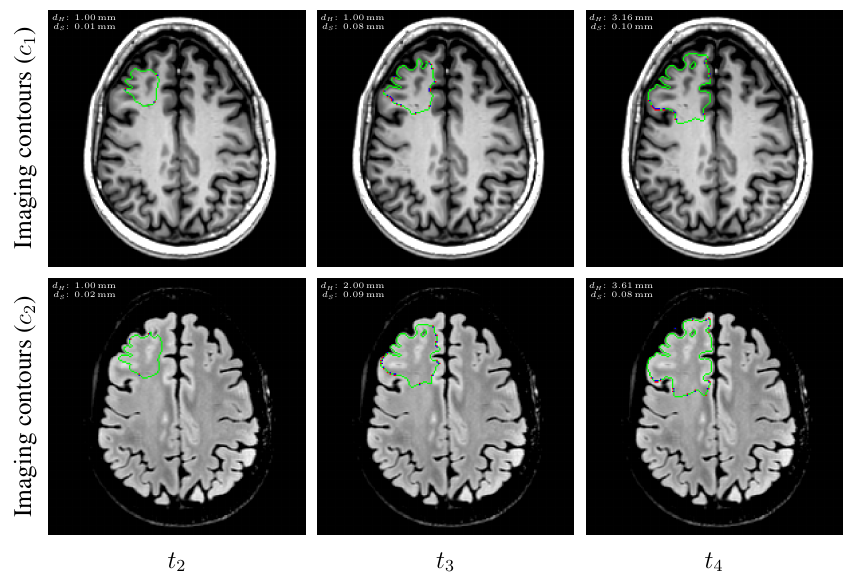
Figure A2. Example of true (1st row) and estimated (2nd row) three-dimensional tumor cell-density distributions at times t 2 − 4 (1st to 3rd column, axial slices) along with the corresponding absolute error maps (3rd row) for a test tumor ( d = 9.52mm 2 year − 1 , ρ = 25.77year − 1 , t 1 = 94d, t 2 = 225d). The imaging contours for threshold values c 1 = 0.80 and c 2 = 0.16 superimposed to the T1 and T2 FLAIR image are depicted in the 4th and 5th rows, respectively. The blue, red, and green segments correspond to the target, prediction, and overlapping contour voxels, respectively. MAE: